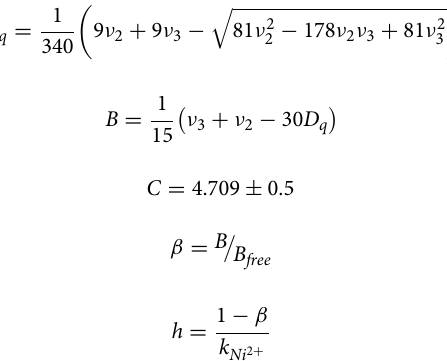
Ligand field parameters; crystal field parameters Dq, Racah parameters B &C, nephelauxetic ratio β , and